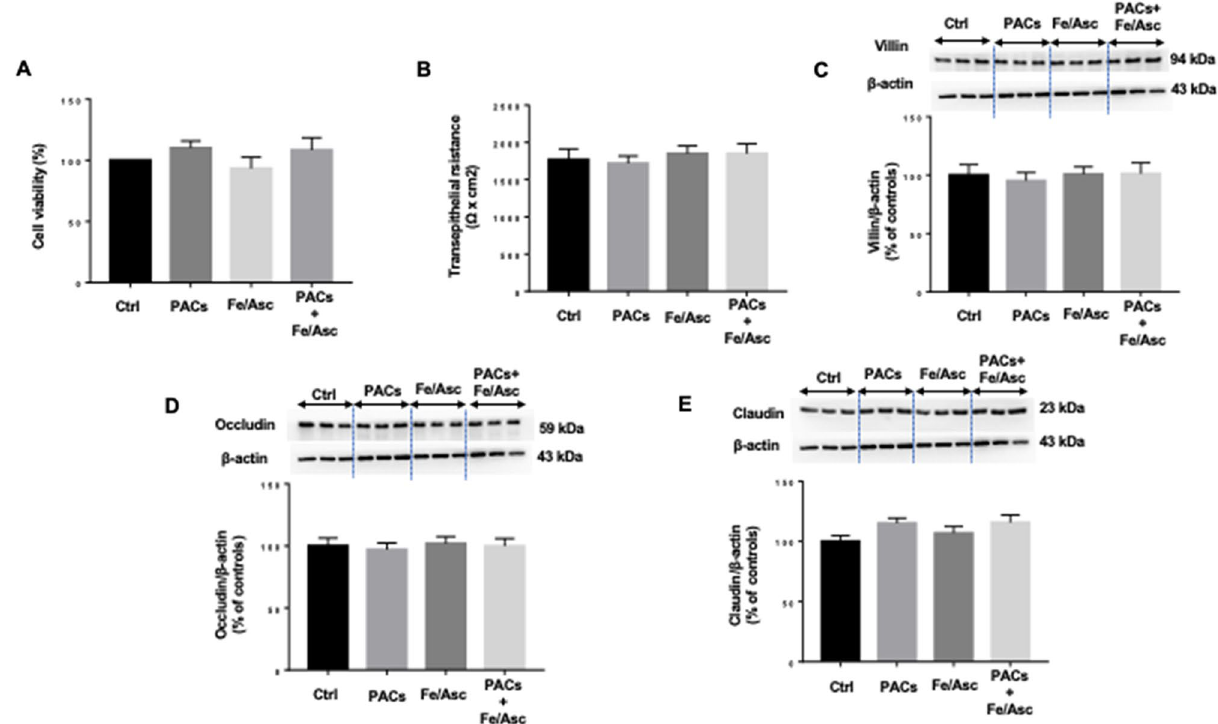
Figure 1. Effects of PACs on cell integrity and viability of Caco2/15 cells. Integrity of Caco 2/15 monolayer was determined by cell viability, differentiation and tight junction assays on fully differentiated state. Proanthocyanidins (PACs, 250 µg/mL) were added to the apical cell compartment for 24 h prior to treatment with Fe/Asc (200 µM/2 mM) for 6 h at 37 °C. ( A ) MTT was used to assay cell viability, and ( B ) transepithelial resistance was also determined. ( C ) Villin, ( D ) Occludin and ( E ) Claudin protein expressions were assessed by Western blot. Results represent the means ± SEM of 3 independent experiments, each in triplicate. A representative Western blot is shown, illustrating an experiment in triplicate on the same gel and at the same